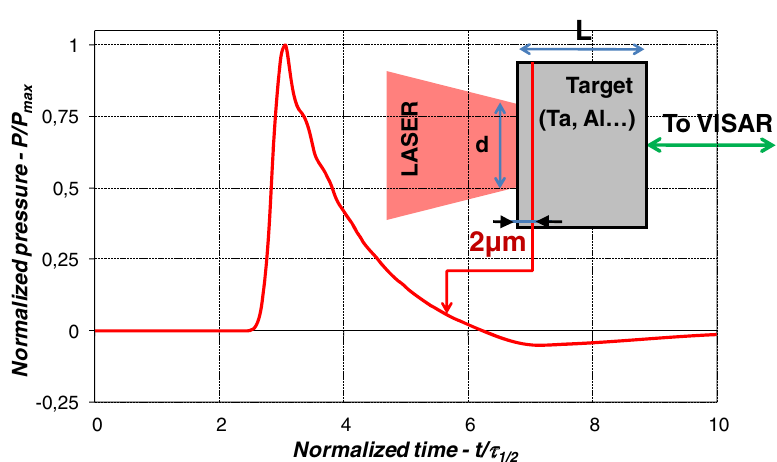
Fig. 1. Calculated pressure loading 2 μ m depth equivalent to a LULI 100TW